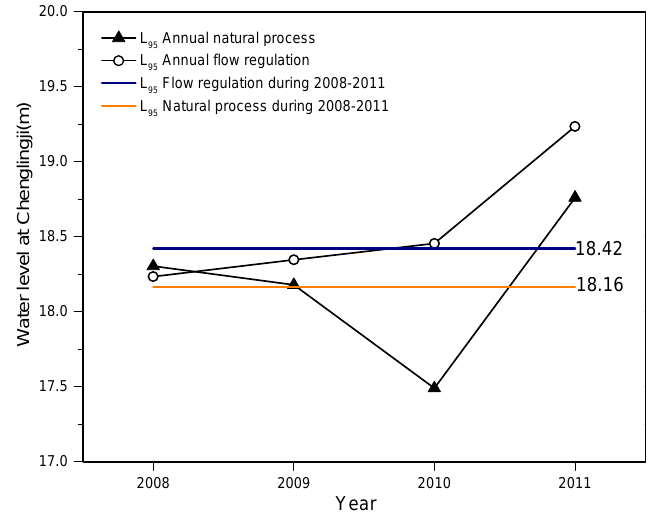
Figure 7. Changes in the water level with a possibility of 95% at the Chenglingji station.